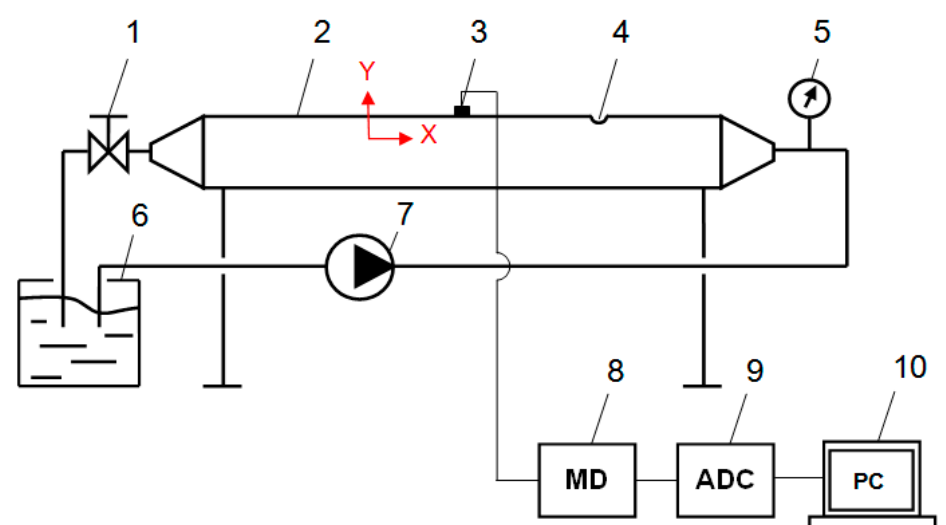
Figure 1. Experimental device: 1—valve; 2—pipeline (length 2 m, external diameter 0.159 m, wall thickness 6 mm); 3—vibration acceleration sensor AR2038R; 4—defect; 5—manometer; 6—capacity;